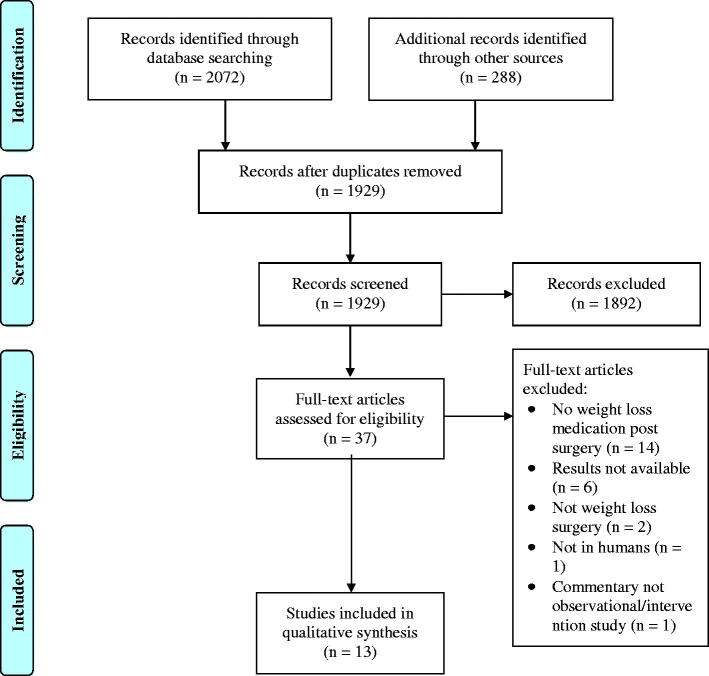
PRISMA Flow-chart.